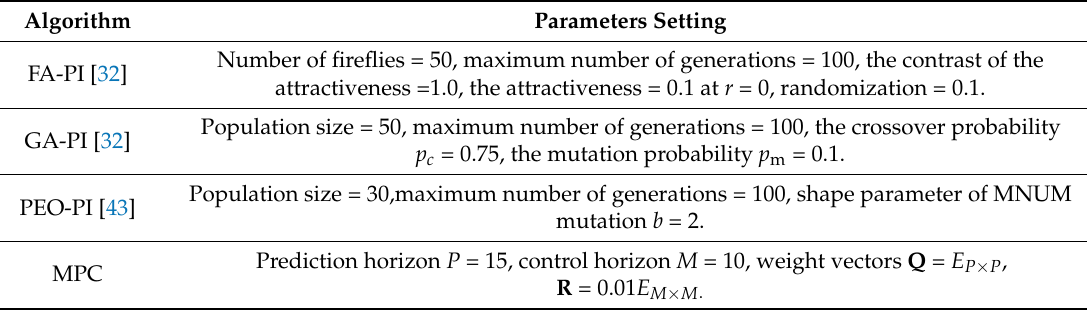
Table 2. Theconditions of